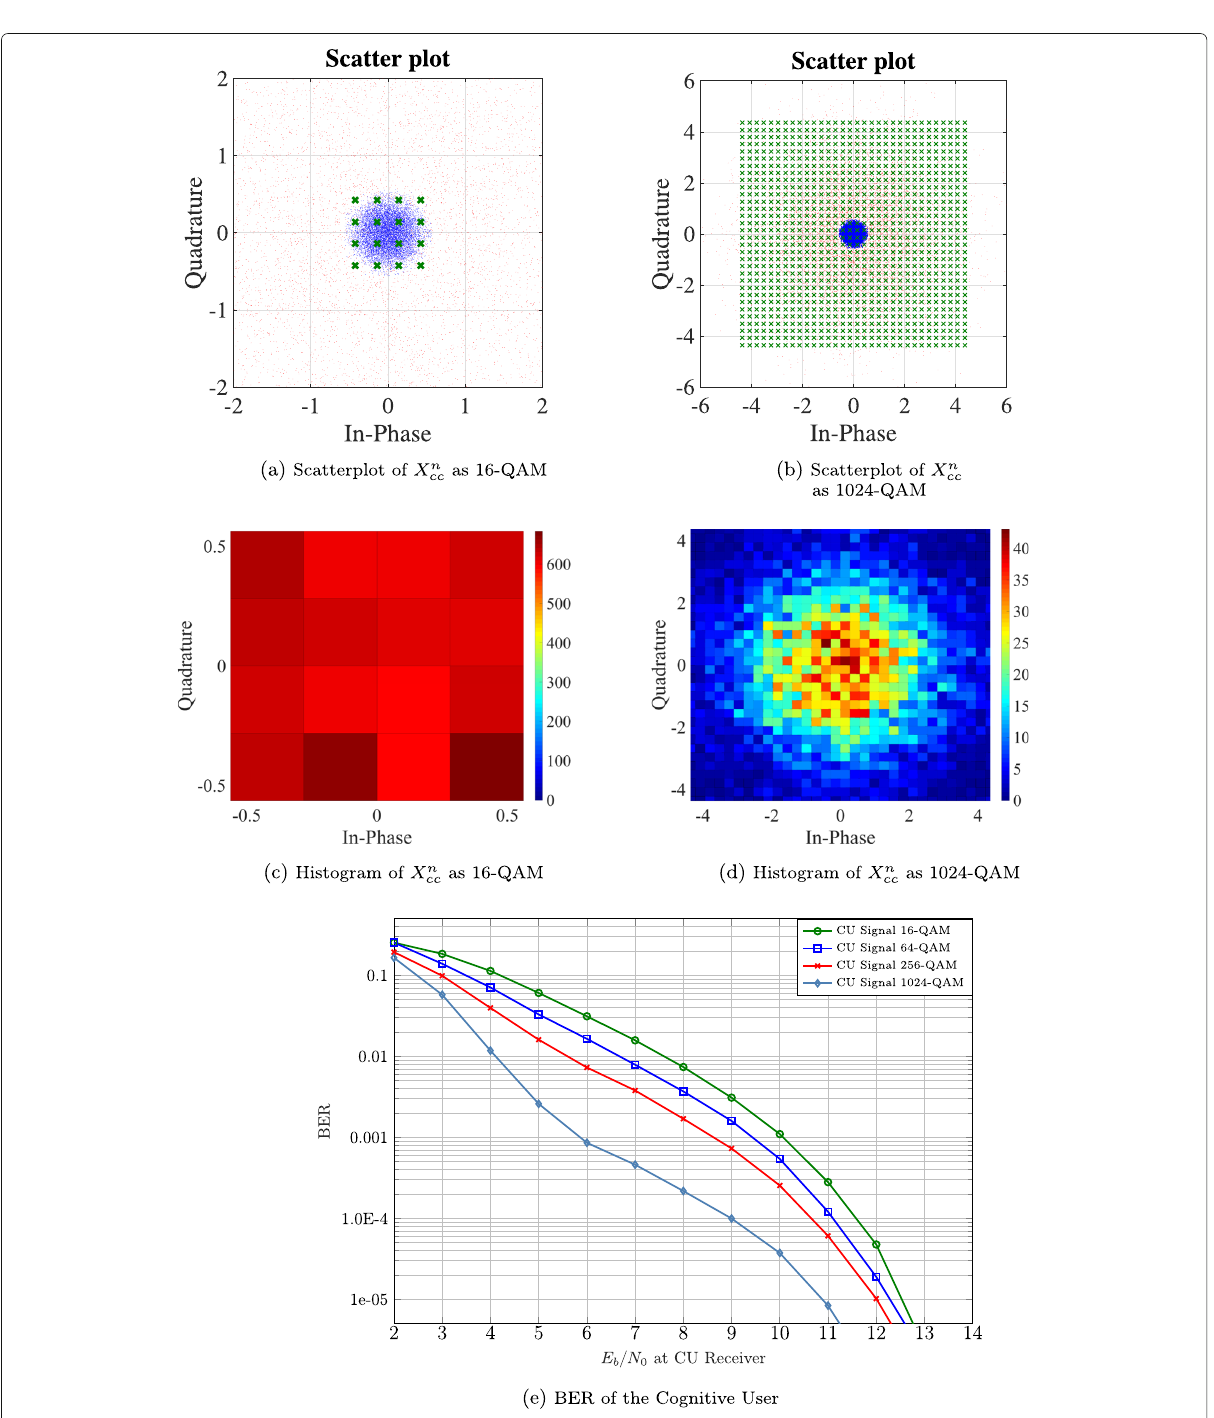
Fig. 13 Results and analysis for CU, considering 10.log ( Pp / Pc ) = 9.5 dB and α = 0.85, according to different constellation